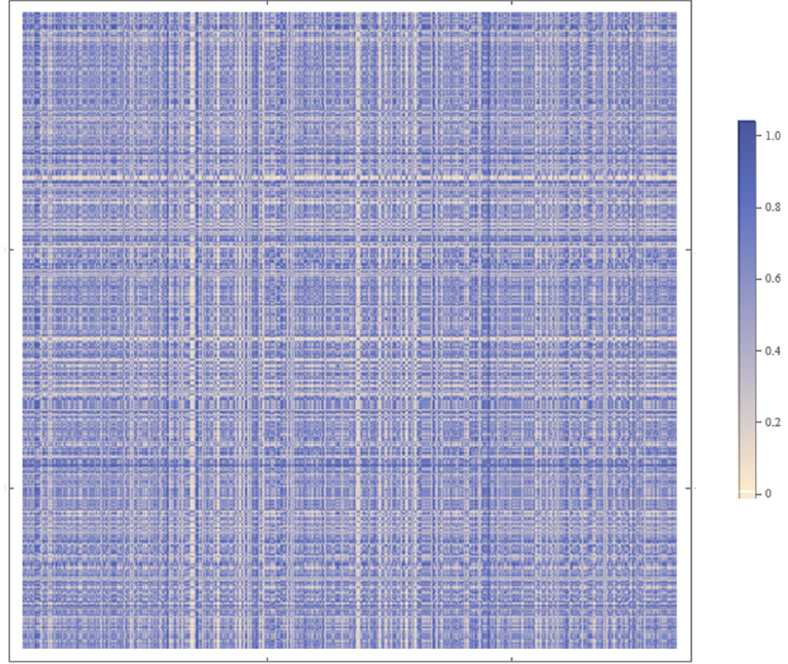
Figure 11. Kernel matrix for the COVID-19 economic period with biweekly sliding window.